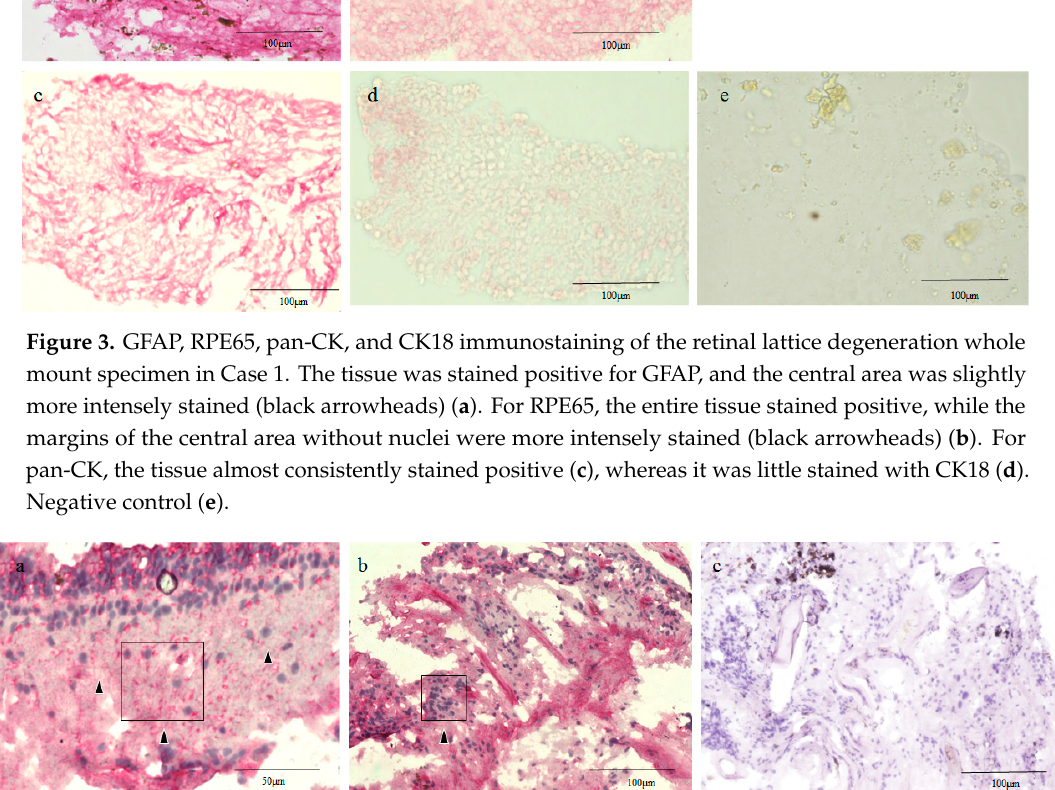
Figure 4. RPE65 and pan-CK immunostaining of the retinal lattice degeneration specimen in Case 2. The whole mount tissue stained positive for RPE65, whereas its central area with a few nuclei was less intensely stained (black arrowheads) ( a ). For pan-CK, the tissue almost consistently stained positive ( b ). Negative control ( c ).